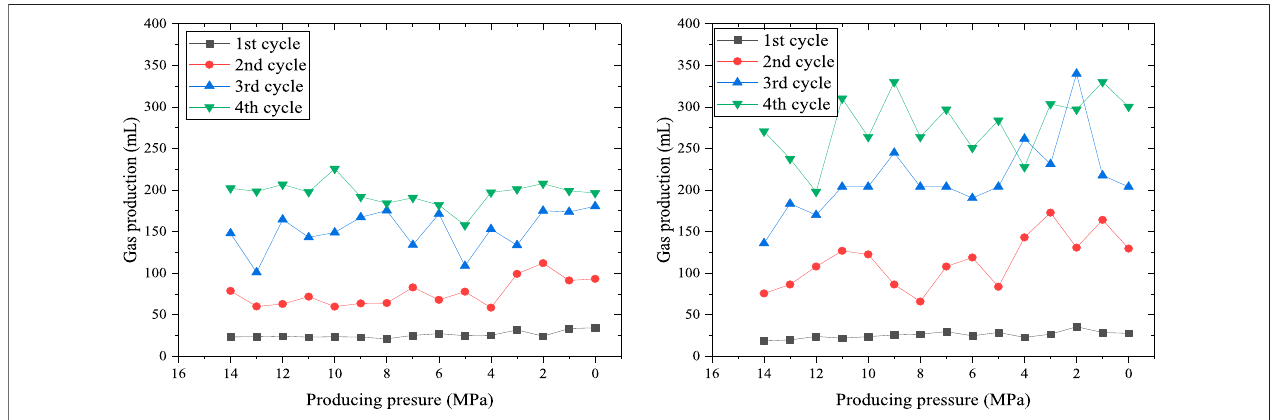
Frontiers in Energy Research |